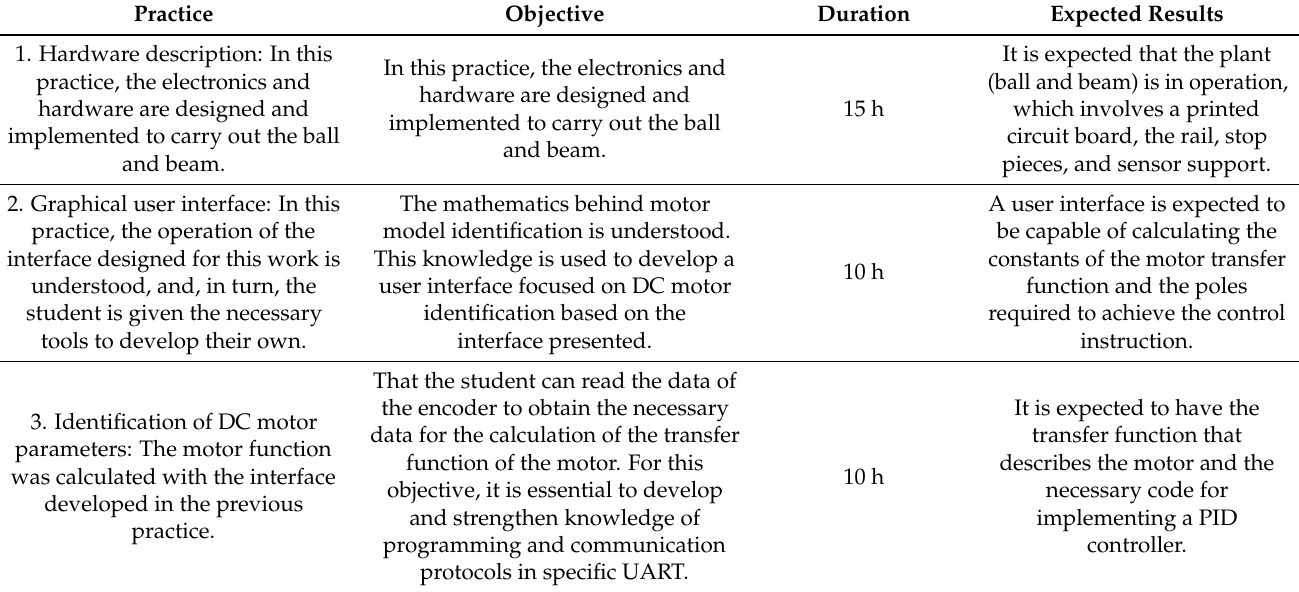
Table 6. Description of the practices that must be carried out for the completion of the